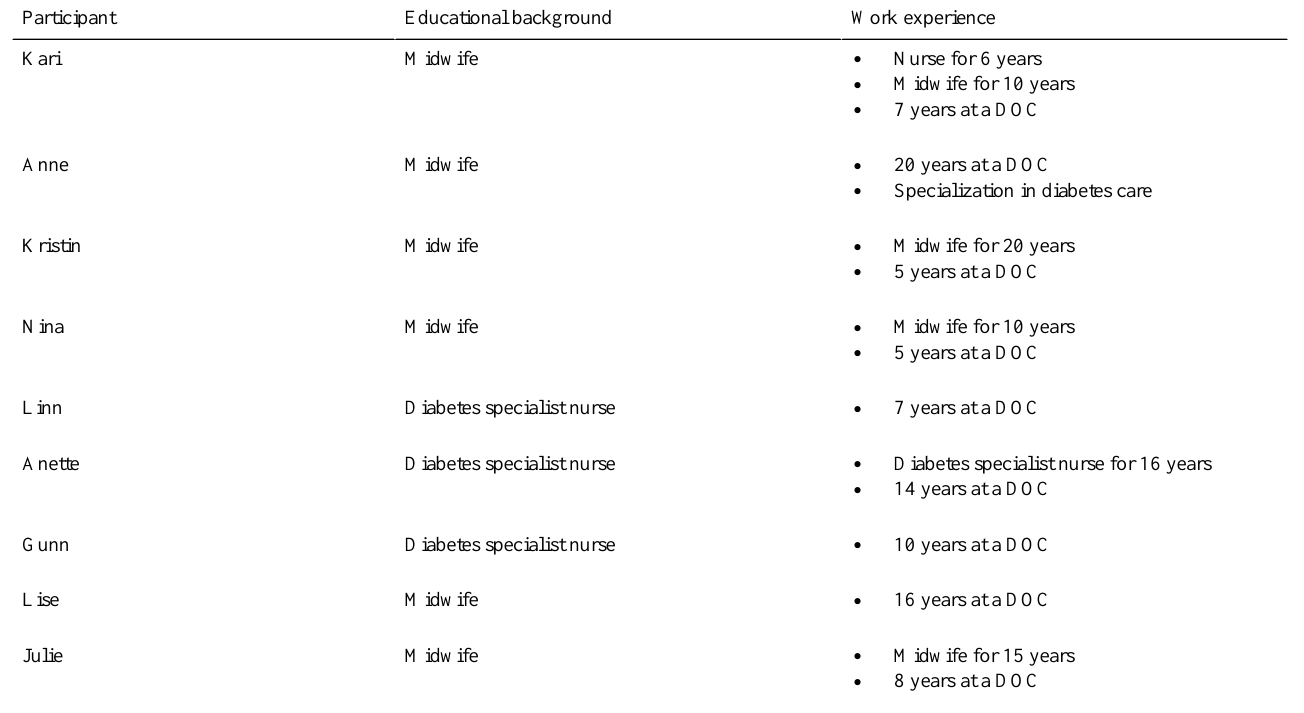
Table 1. Educational backgrounds and work experiences of the study participants. Fictional names have been used.